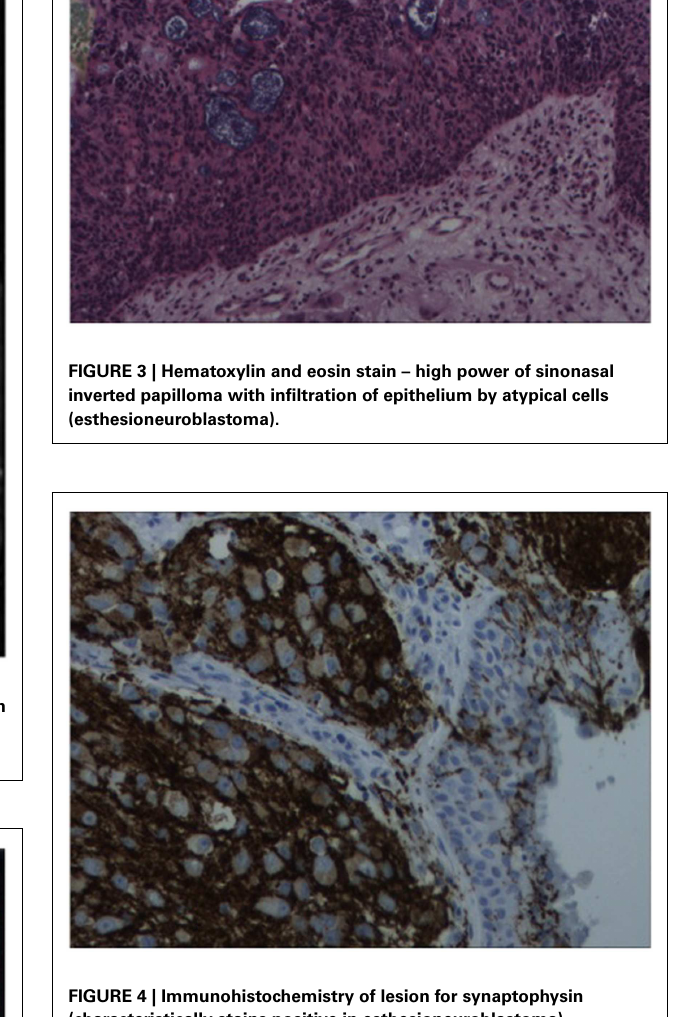
(EBNA-1) by polymerase chain reaction (PCR) and Epstein–Barr virus encoded RNA (EBRER) by immunohistochemistry. Further immunohistochemical analysis showed the neoplastic cells to be focally positive for pan-keratin, neuron-specific enolase (NSE), synaptophysin ( Figure 4 ), epithelial membrane antigen (EMA), and vimentin. Additionally, rare immunoreactivity was noted in the subepithelial tumor cells for chromogranin, neurofilament ( Figure 5 ), and GFAP. The specimen tested negative for leuko- cyte common antigen (LCA), latent membrane protein (LMP), S-100, CD20, CD3, desmin, and smooth muscle actin. The Ki- 67 proliferation index was reported at approximately 70%. The immunohistochemical profile is consistent with a diagnosis of a collision tumor of high-grade ENB with extensive involvement of overlying schneiderian